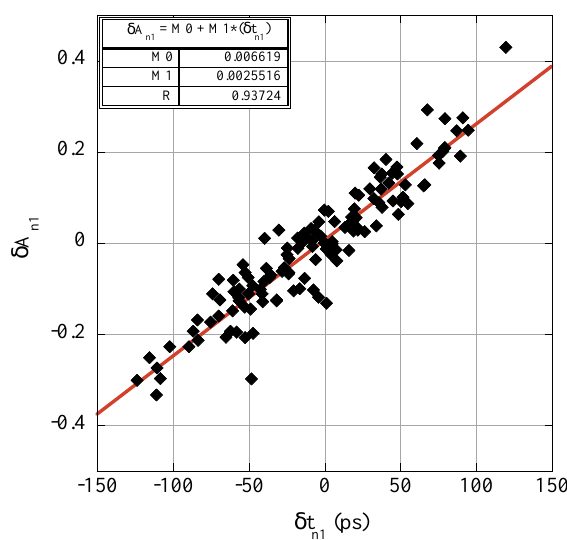
FIG. 18. (Color) A plot of the change in the asymmetry factor from bunch one to bunch n as a function of time deviation from bunches one to bunch n in the presence of the longitudinal